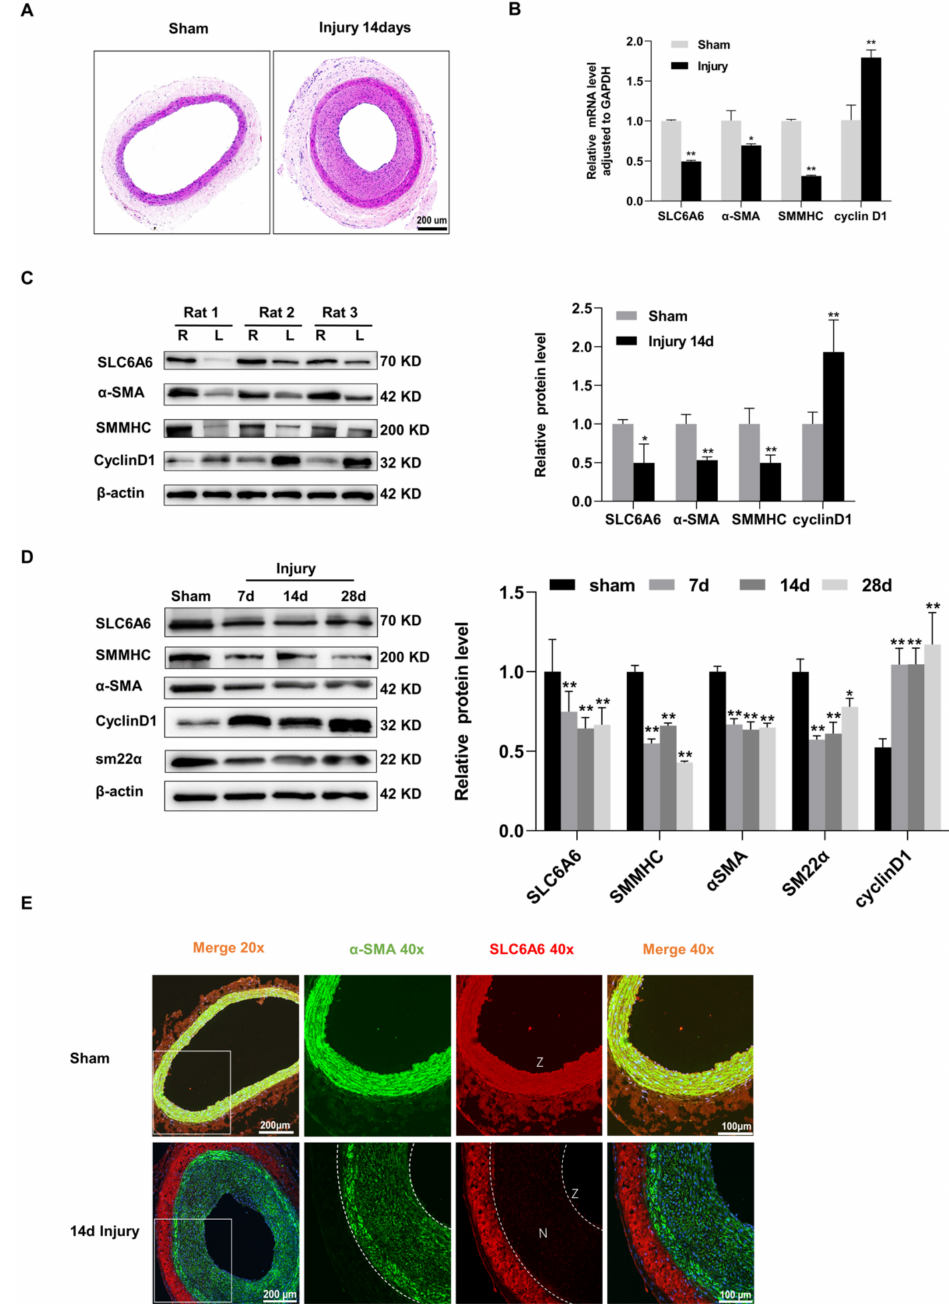
Figure 2. SLC6A6 was downregulated during neointimal formation. ( A ) Representative HE of sham and injured carotid arteries in rats. Scale bar: 200 µ m (100 × ). ( B ) qRT‑PCR analysis showing mRNA (SLC6A6, α ‑SMA, SMMHC, cyclin D1) expression levels in sham and injured carotid arteries. Data are normalized to GAPDH; N = 3; * p < 0.05, ** p < 0.01 vs. sham. Data are represented as mean ± SD. ( C ) Western blot analysis of SLC6A6 and contractile VSMC‑specific proteins (SMMHC, α ‑SMA) and cell proliferation marker cyclin D1 in sham (right, R) and injured (left, F) carotid arteries. Data are normalized to β ‑actin; N = 3; * p < 0.05, ** p < 0.01 vs. sham. Data are represented as mean ± SD. ( D ) Protein expression levels of SLC6A6, SMMHC, α ‑SMA, SM22 α , and cyclin D1 in carotid arteries at 7, 14, and 28 days post injury. Data are normalized to β ‑actin; N = 3; * p < 0.05, ** p < 0.01 vs. sham. Data are represented as mean ± SD. ( E ) Representative images of dual immunofluorescence staining of SLC6A6 (red) and α ‑SMA (green) in sham and injured carotid arteries. N, neointimal; Z, zoom of vascular tissue. Scale bar: 200 µ m (200 × , left); scale bar: 100 µ m (400 × ,